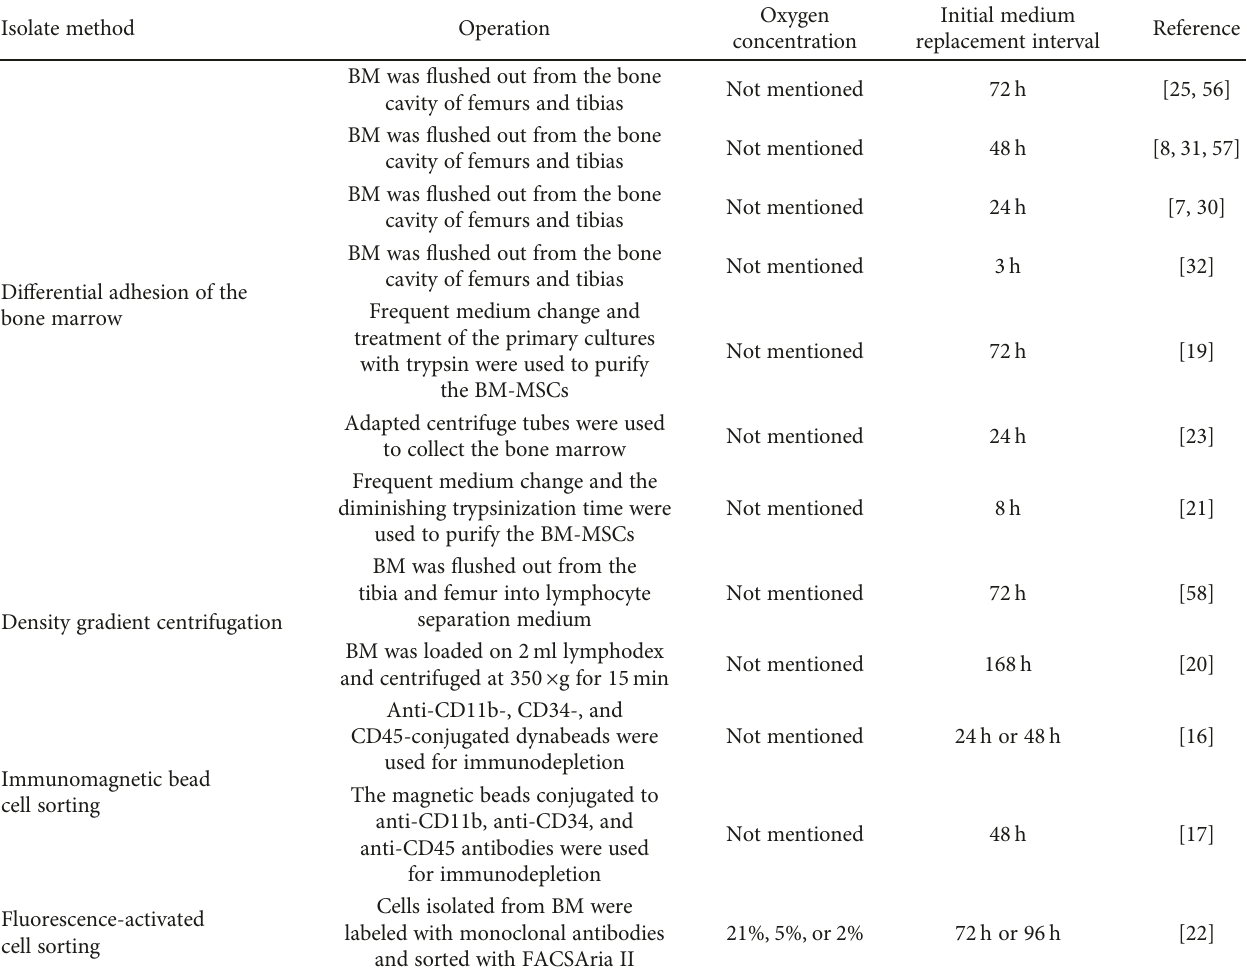
Table 2: Summary of studies describing isolate methods and in vitro culture conditions for mouse BM-MSCs. Isolate